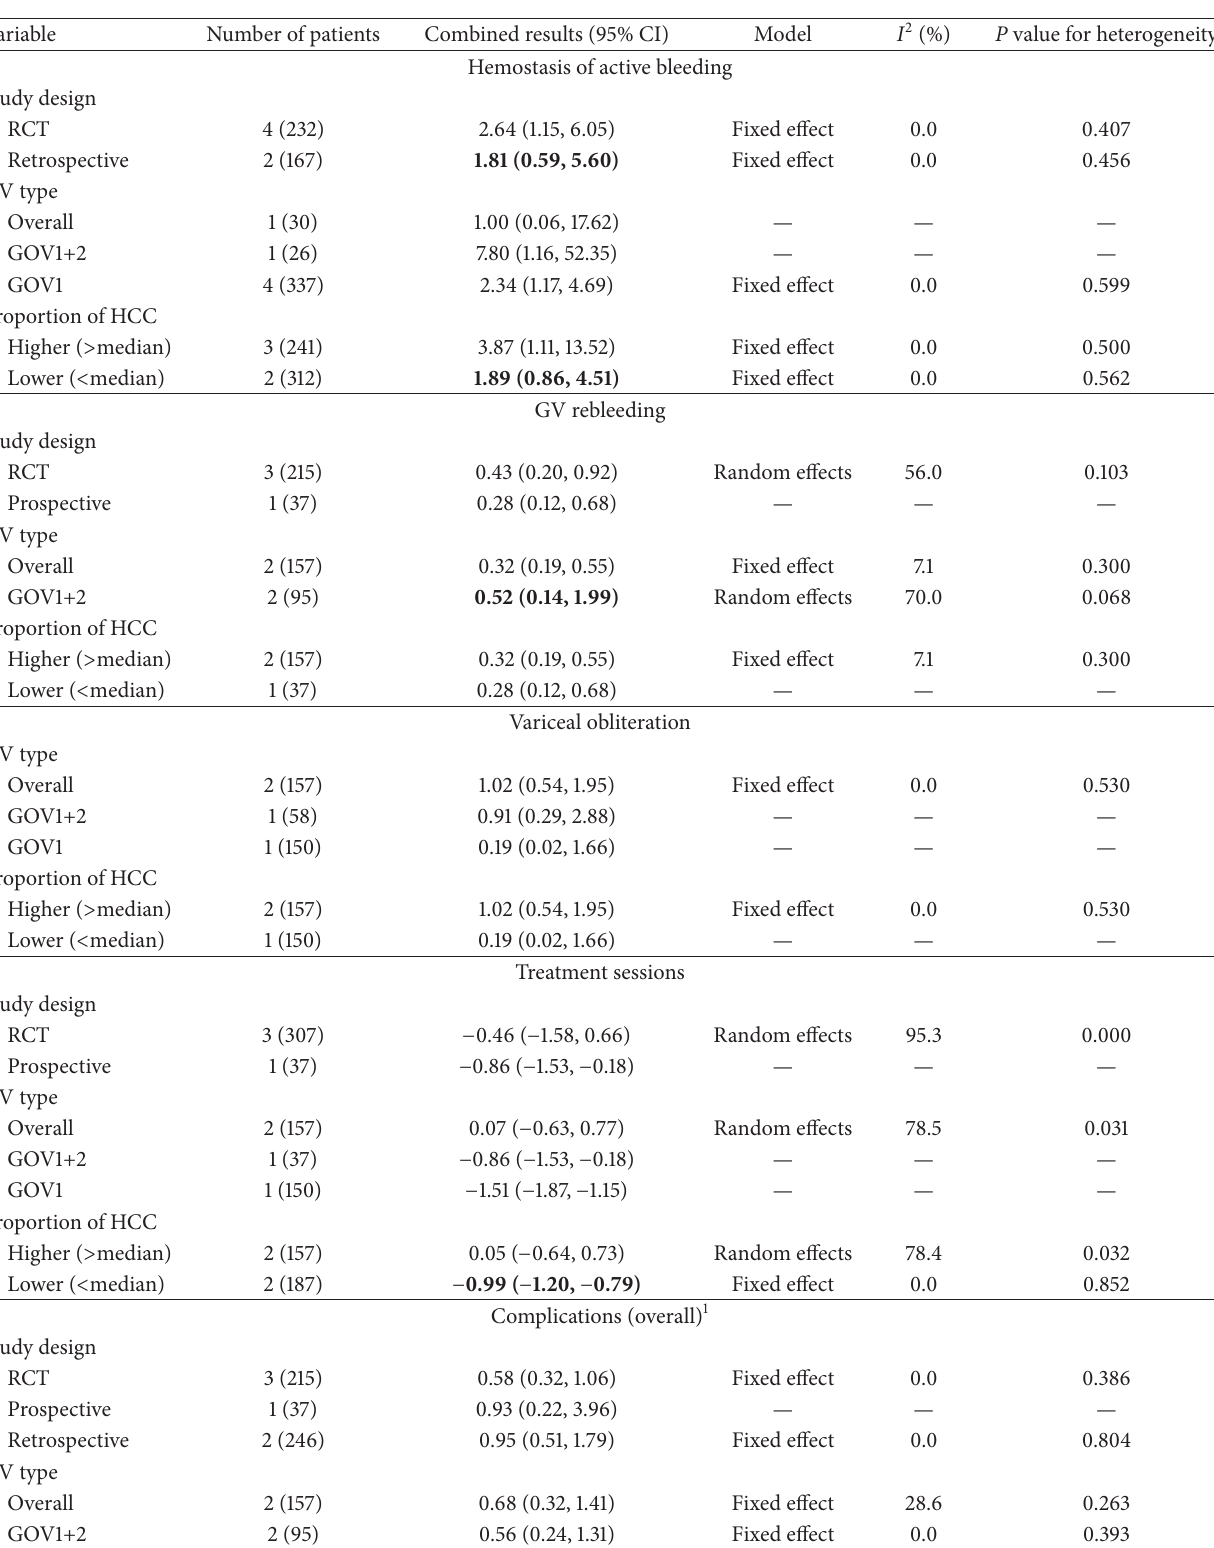
Table 4: Results of subgroup